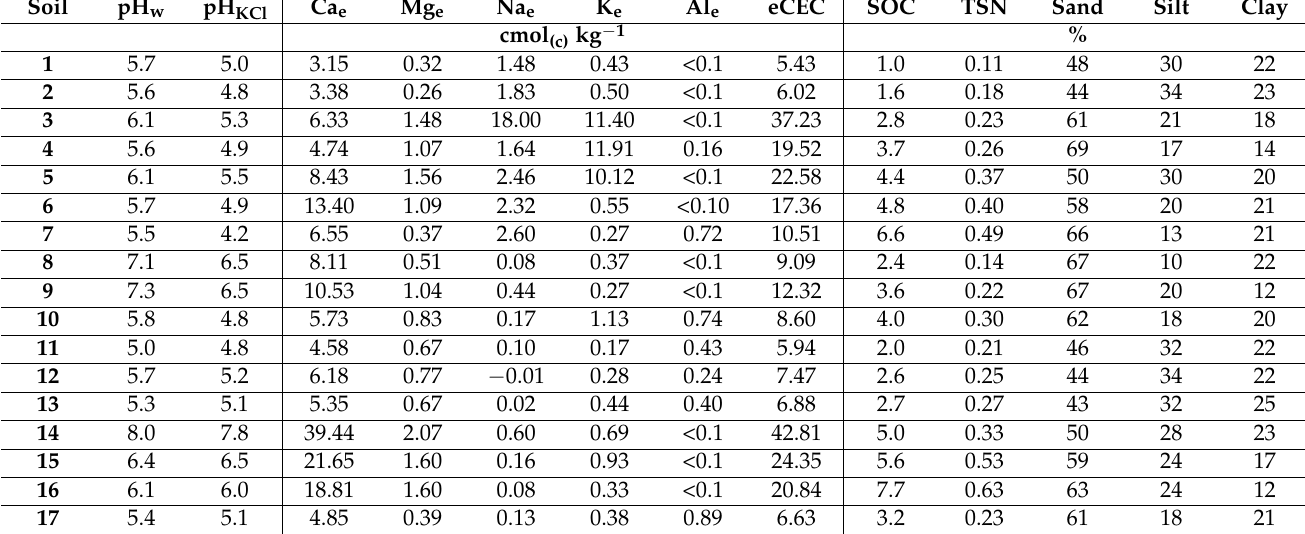
Table 2. Main physicochemical properties of the soils studied. pH w : pH in water; pH KCl : pH